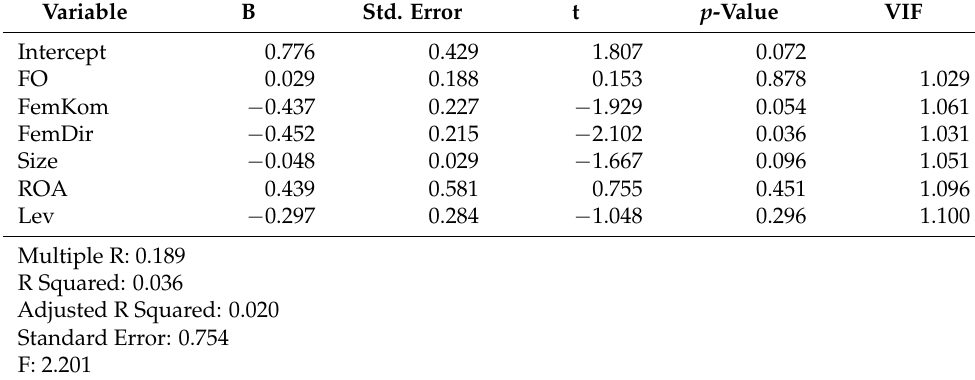
Table 4. Result of multiple regression